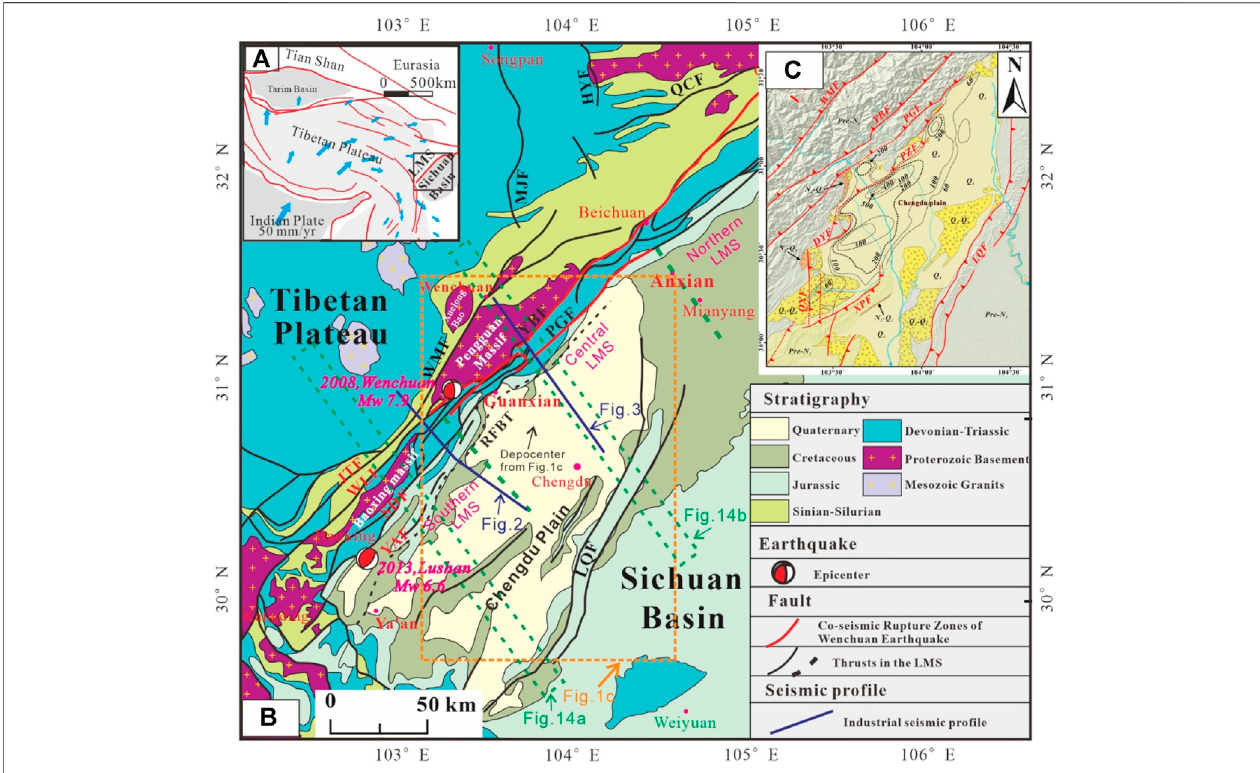
FIGURE 1 | Regional map of the LMS fold-thrust belt (A) and its geological structure map (B) (modi fi ed from Sun et al., 2016, Co-seismic rupture zones from Xu et al., 2009). (C) shows the thickness contour lines (100 m interval) of the Upper Pliocene and Quaternary (syntectonic sedimentary strata) beneath the Chengdu plain (cited from Li Z. et al., 2018). JTF, Jintang Fault; WLF, Wulong Fault; WMF, Wenxian-Maoxian Fault; SDF, Shuangshi-Dachuan Fault; PGF, Pengxian-Guanxian Fault; YBF, Yingxiu-Beichuan Fault; YAF, Yaan Fault; LQF, Longquanshan Fault; QCF, Qingchuan Fault; MJF, Minjiang Fault; HYF, Huya Fault; RFBT, Range Front Blind